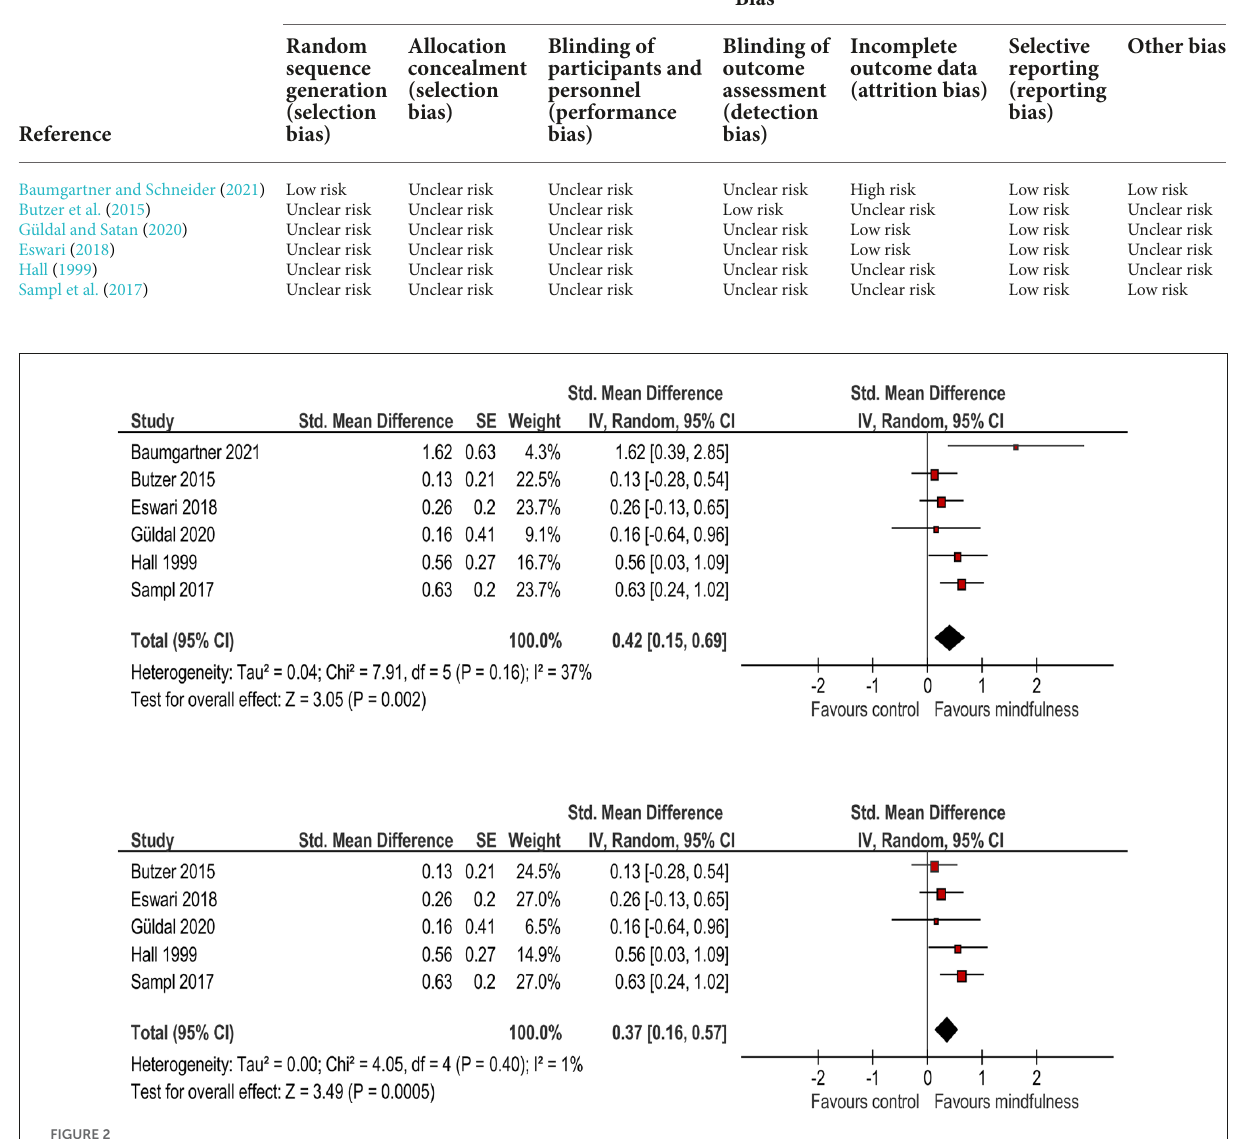
TABLE 2 Risk of bias assessment of the included studies using the Cochrane risk of bias tool.